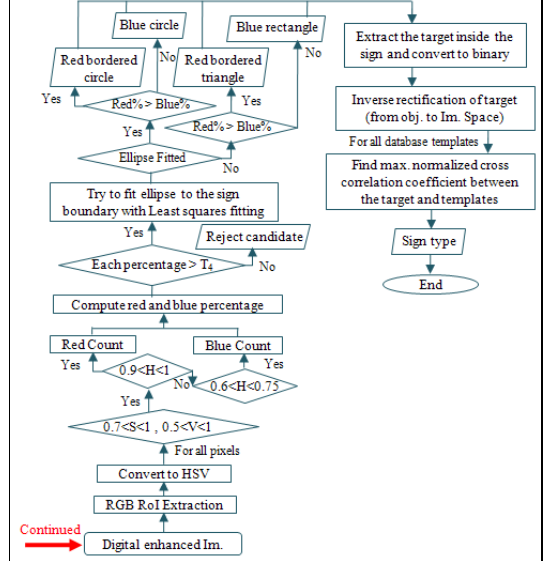
Figure 3. The proposed DRL algorithm